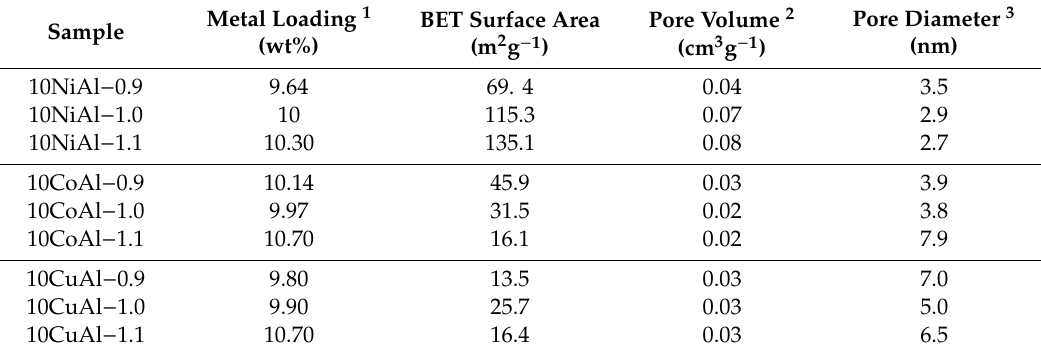
Table 2. Elemental analysis and textural properties of the 10MAl − x calcined